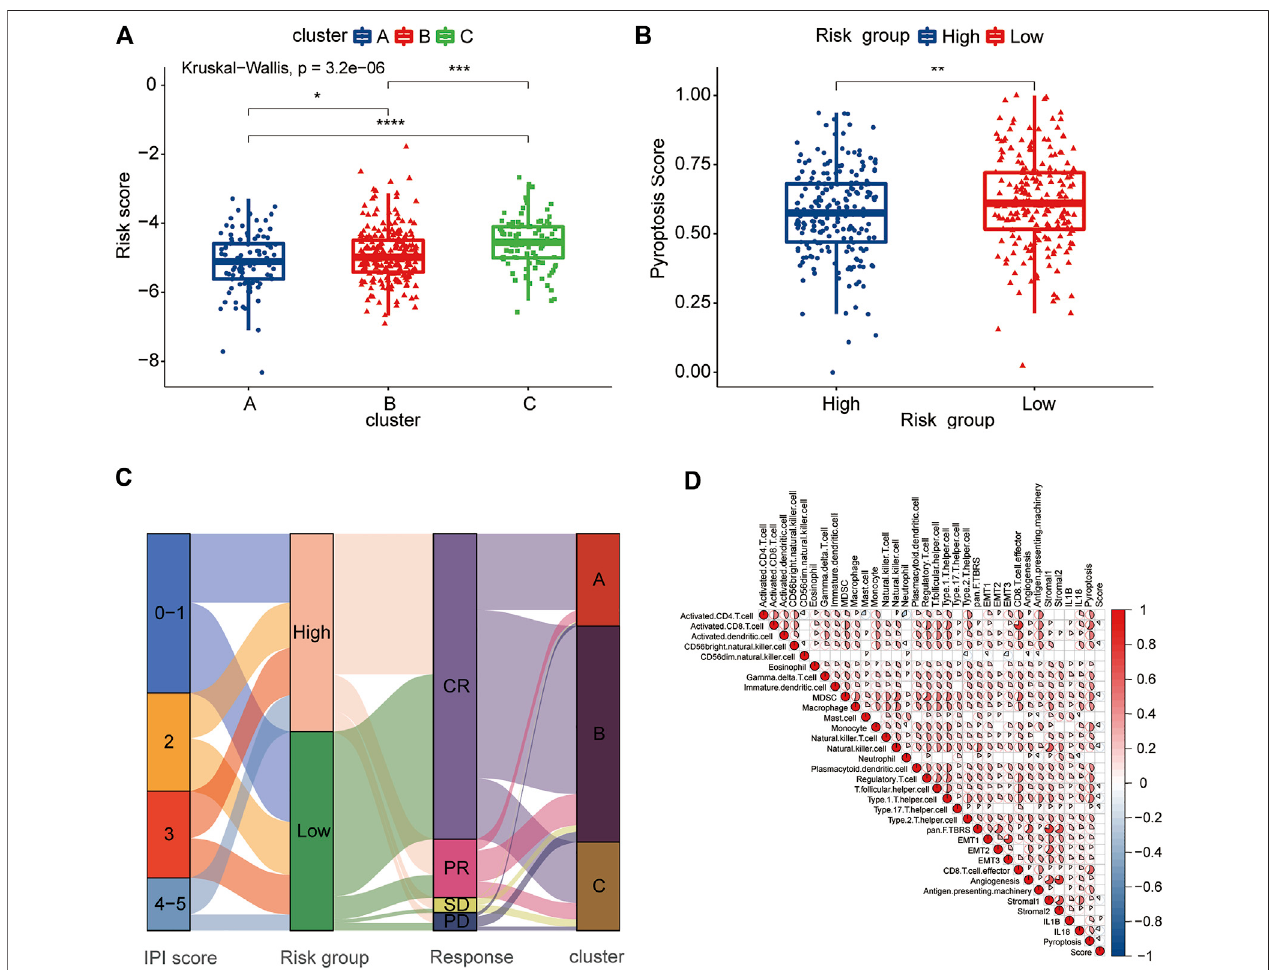
FIGURE 8 | Clinical and TME characteristics of pyroptosis risk score and pyroptosis risk subgroup. (A) Comparison of the pyroptosis risk score among the three pyroptosis-related clusters. The blue box represents cluster A, the red box cluster B and the green box cluster C. (B) Comparison of the pyroptosis signature score between the two pyroptosis risk groups. Blue box, high-risk group; red box, low-risk group. (C) Alluvial diagram showing the changes in the IPI score, pyroptosis risk group, RCHOP regimen treatment response and pyroptosis-related clusters. (D) Correlation among the TME, expression of IL-1 β and IL-18, pyroptosis signature score and pyroptosis score. Redrepresentsapositivecorrelation,and blue represents anegative correlation.The colordepthrepresentsthe strength ofthecorrelation.